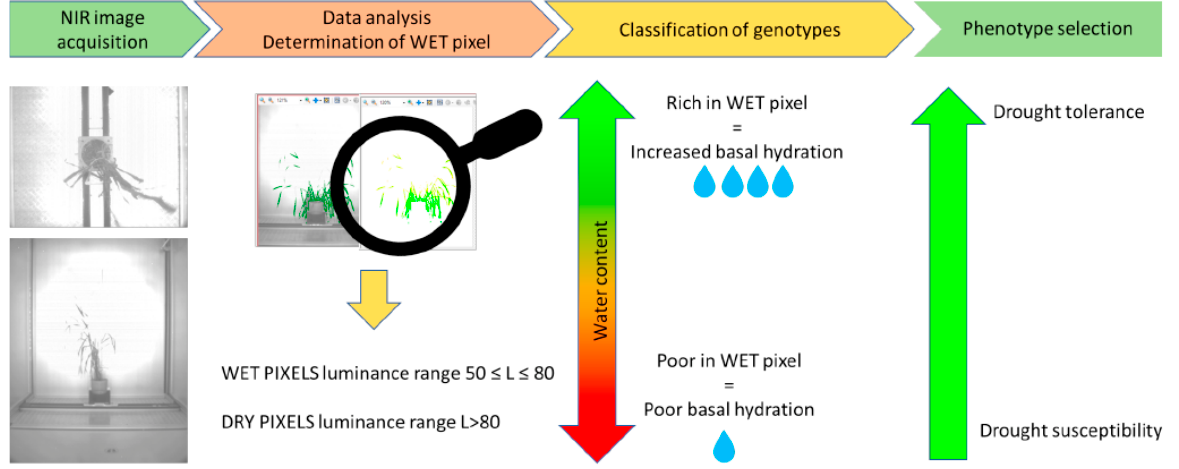
Figure 1. Approach used in the present study. Graphical abstract.